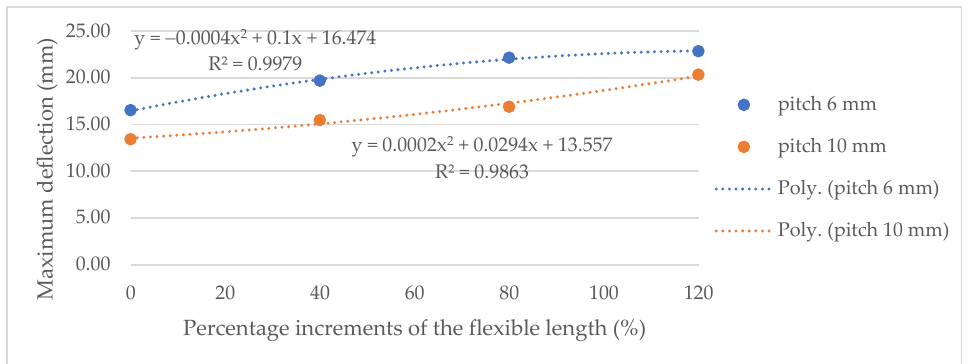
Figure 12. The variation in the MOR with an incremental increase in the flexibilization length, for two values of the model pitch.